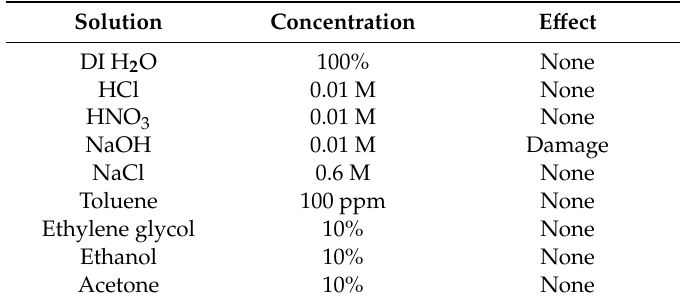
Table 2. Results of the stability tests of GO membranes in di ff erent solutions for 3 months. “None” refers to a membrane that, after the stability test, is not only compact at visual inspection, but is still possible to be used without cracking its structure during the filtration test. Refer to Table S4 in the Supporting Information for further details.